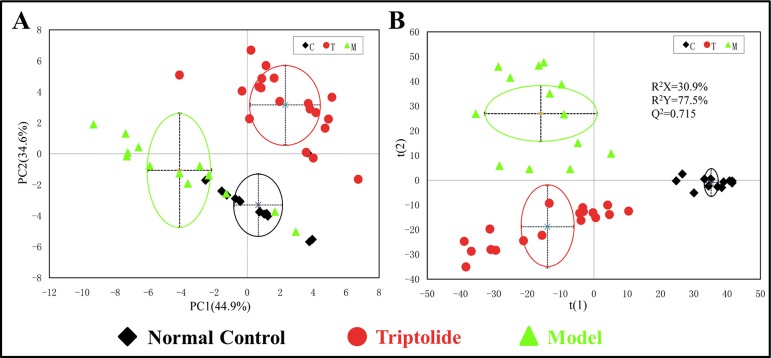
(A) PCA and (B) PLS-DA score plots of mouse plasma samples.